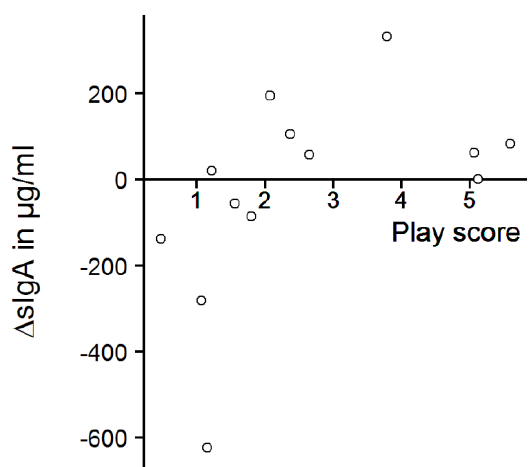
Figure 7. ∆ sIgA and play score. ∆ sIgA = (sIgA concentration after play test) minus (sIgA concentration before play test); Spearman’s rank correlation, n = 13, r = 0.69, p = 0.012.